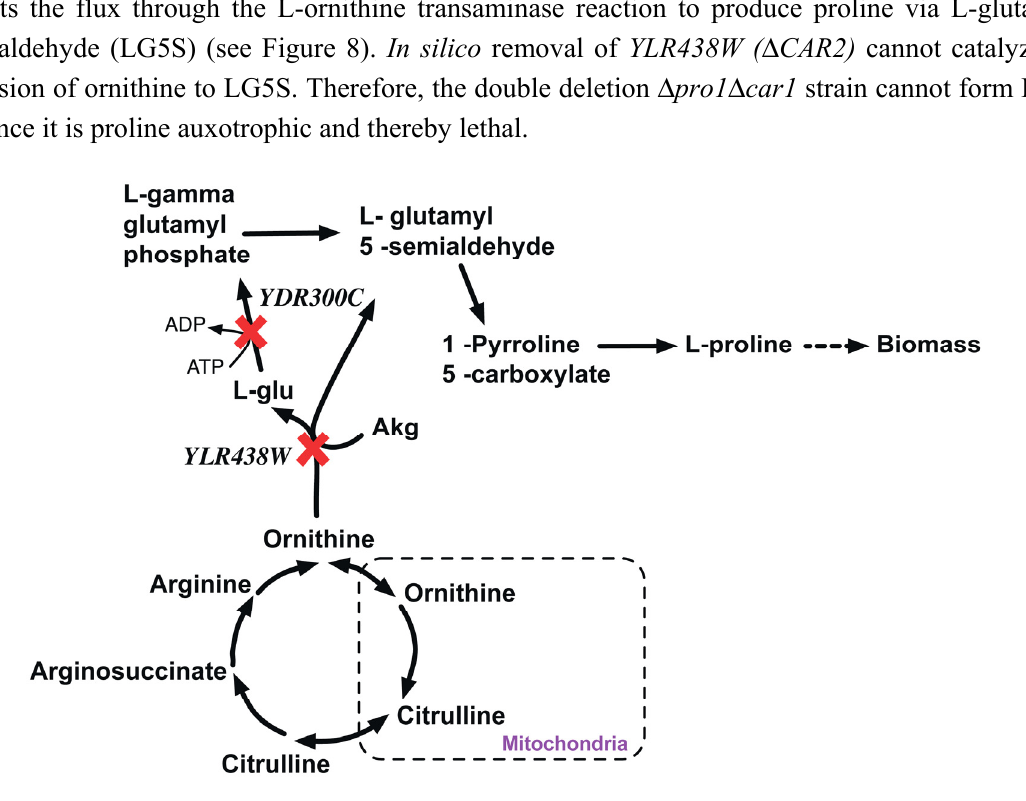
Figure 8. Proline metabolism disrupted due lethal gene pair knockout. YDR300C and YLR438W are genes encoding the proteins to catalyze the alternate paths for the formation of L-Gamma glutamyl phosphate that synthesizes in L-Proline. Red crosses mark knocked out